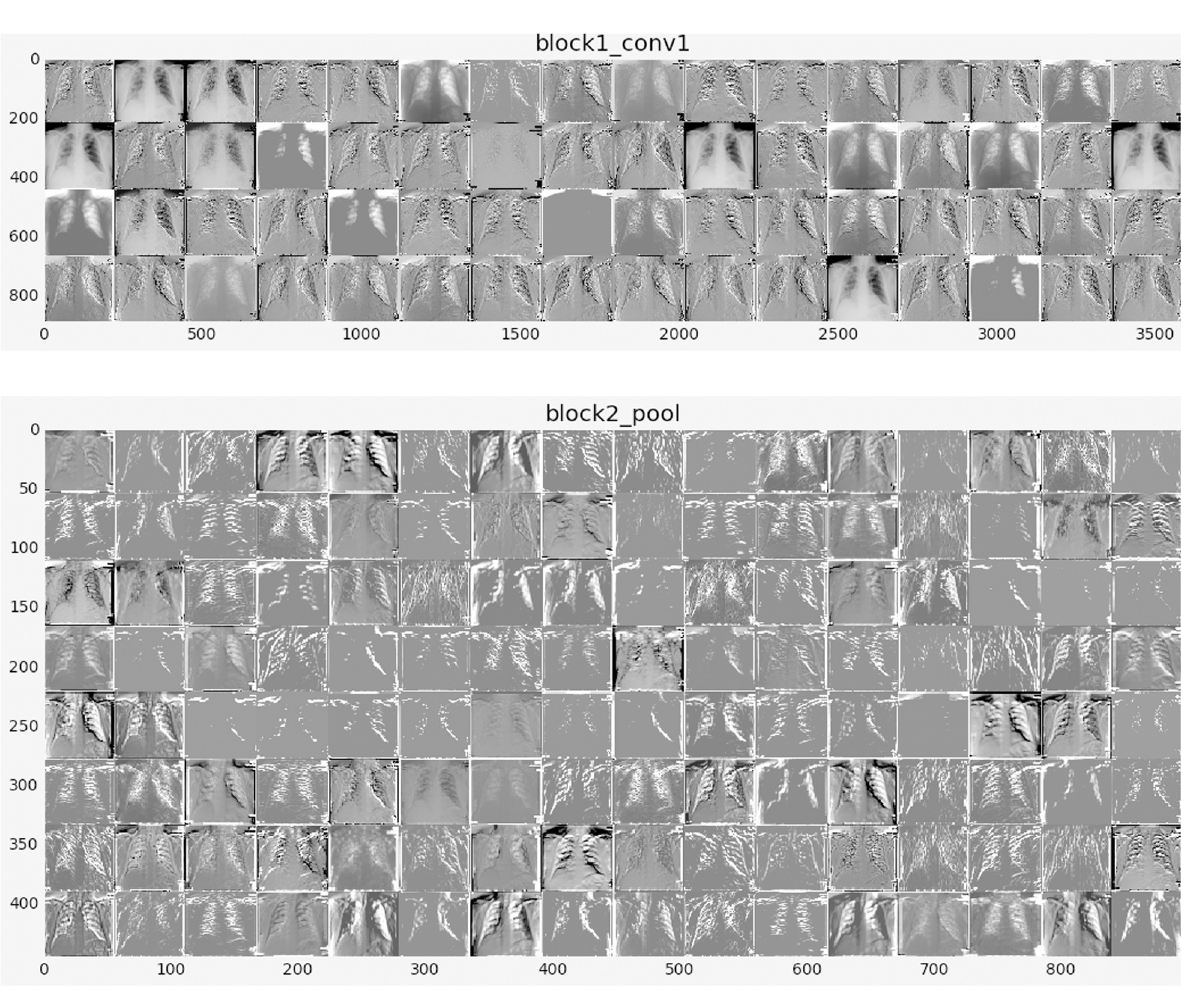
Fig 7. Visual feature maps in first layer and deep layer.